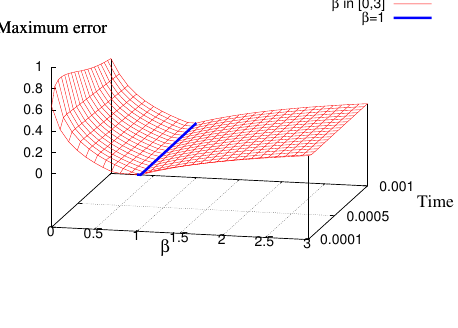
Figure 9. Maximum error obtained for different values of β for the column problem with k = 10 − 9 and N = M =